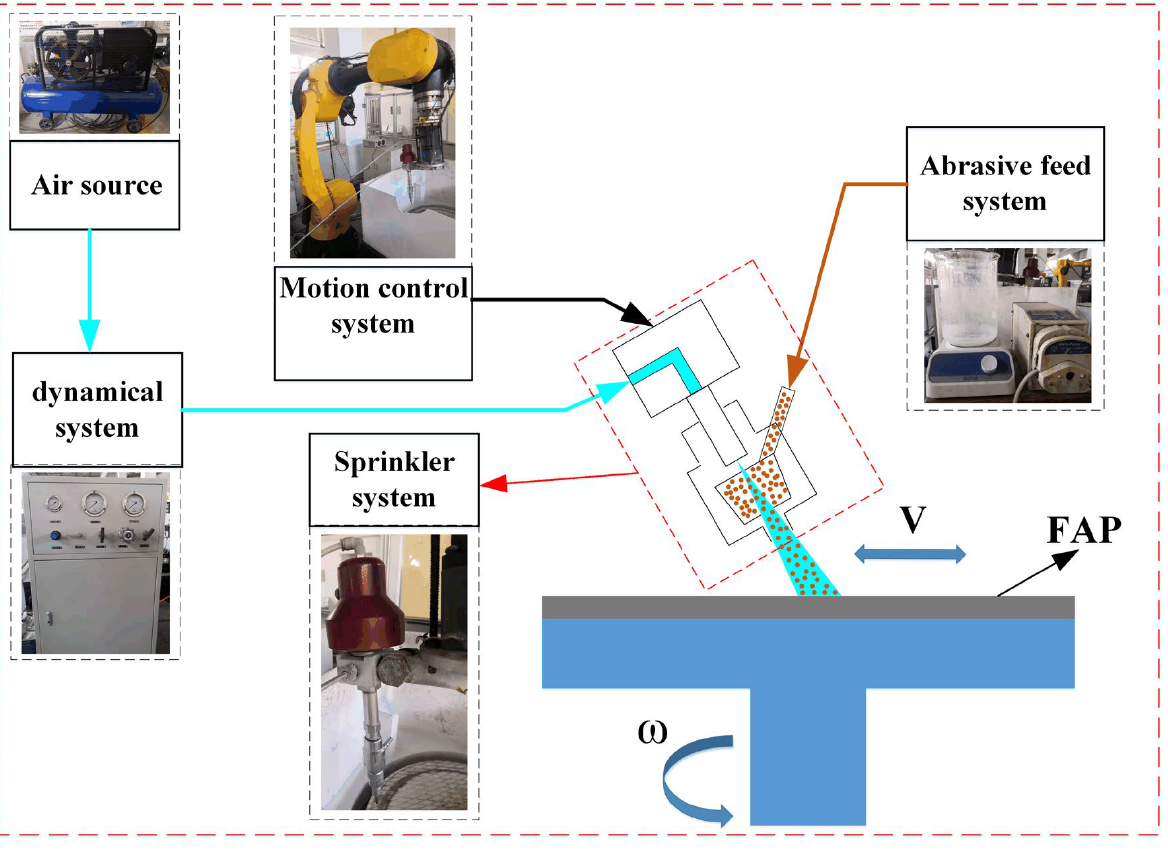
Figure 1. Working principle of AWJ.